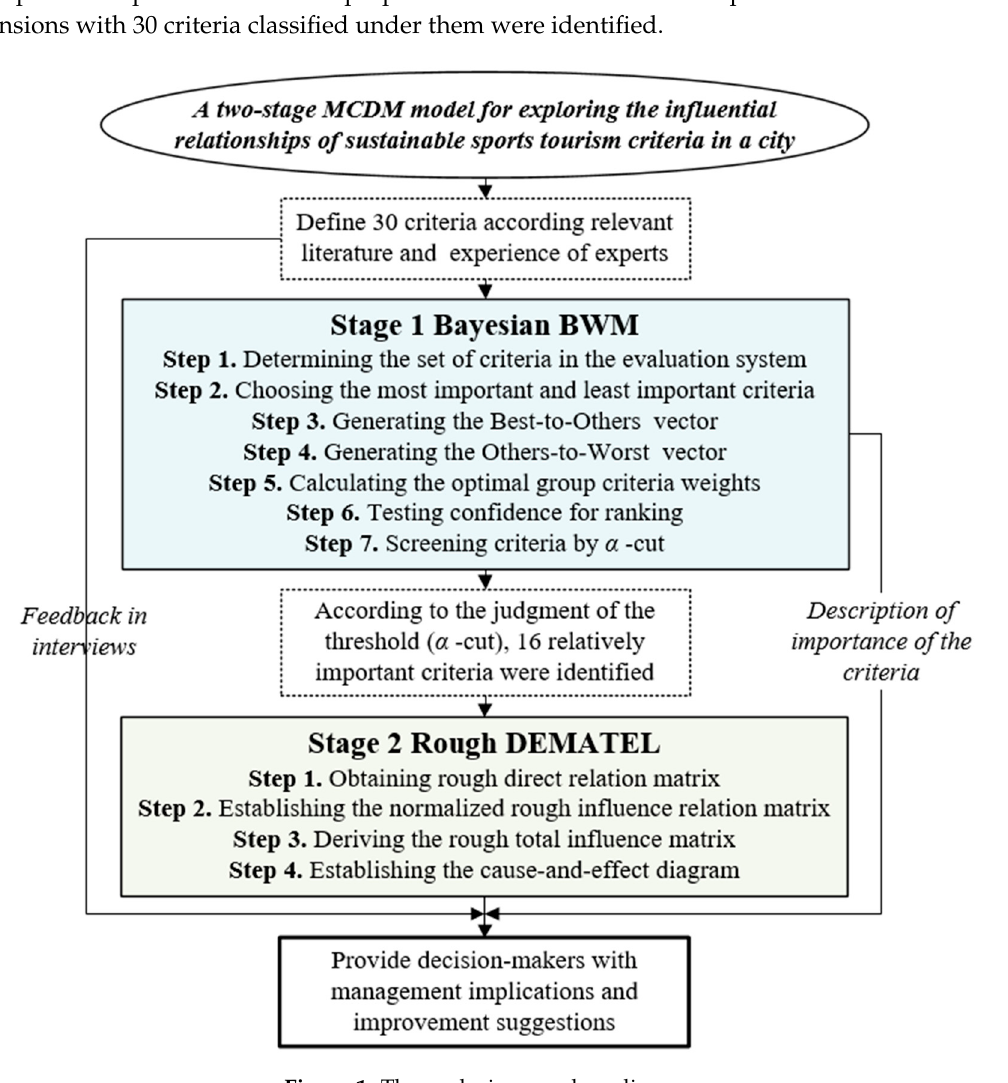
Figure 1. The analysis procedure diagram.